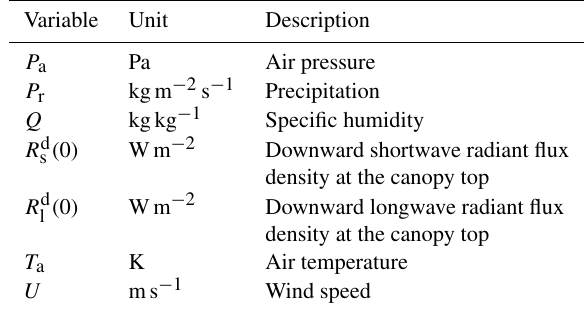
Table 1. Meteorological